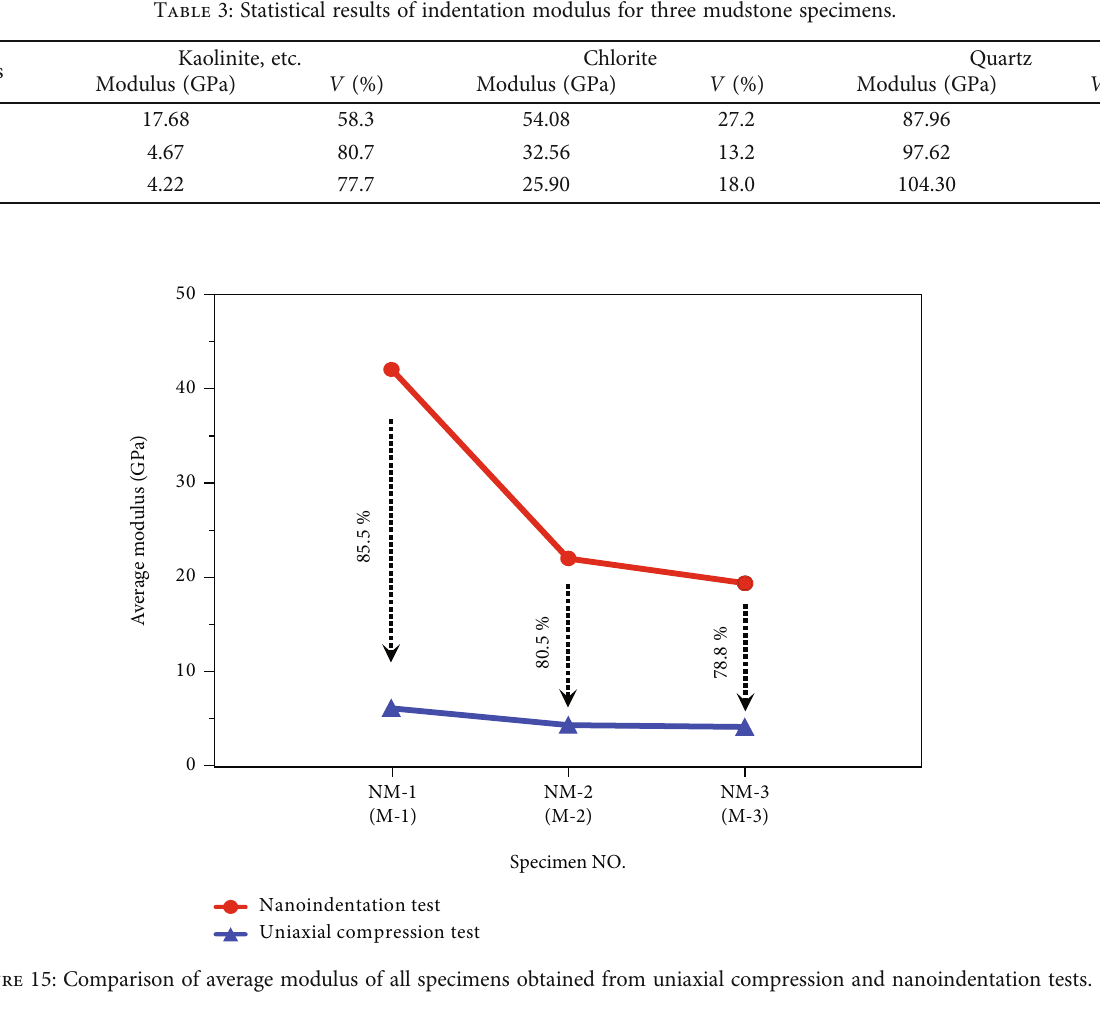
Table 4: Test results of homogenization and macroscopic